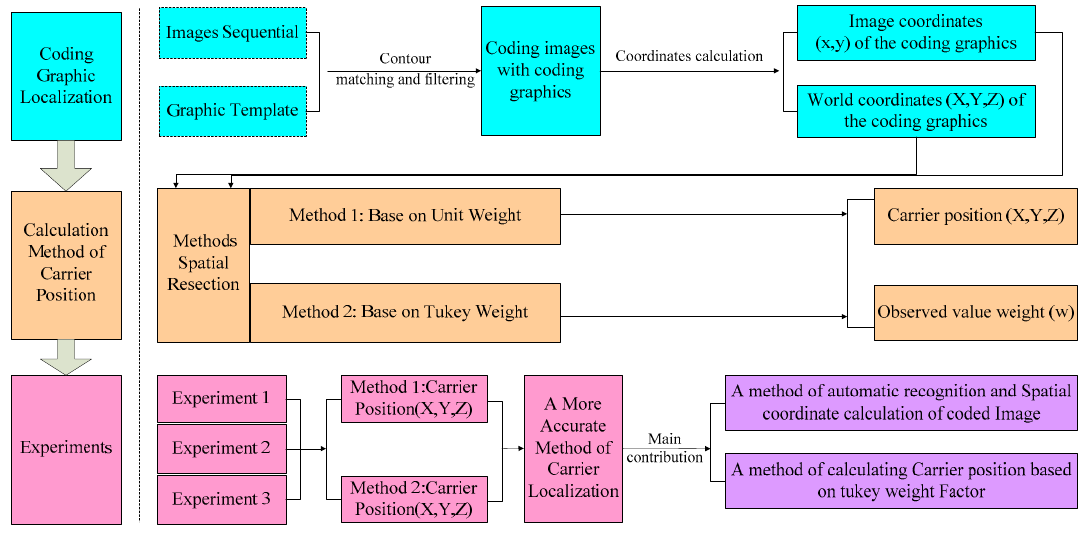
Figure 1. Technical flowchart.